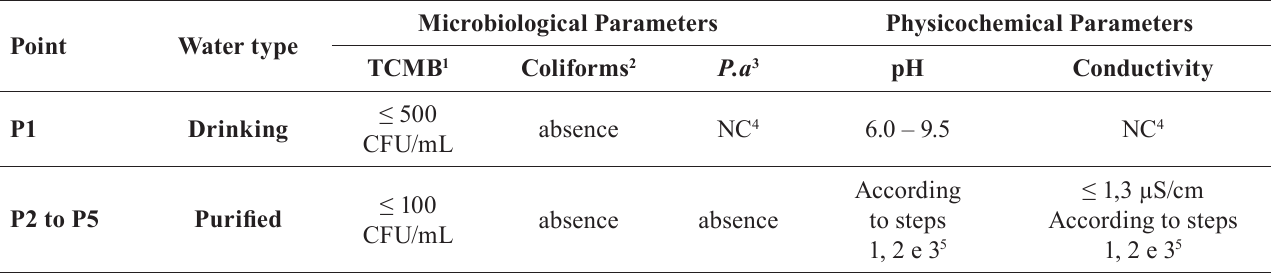
TABLE III - Microbiological and physicochemical limits for drinking and purified